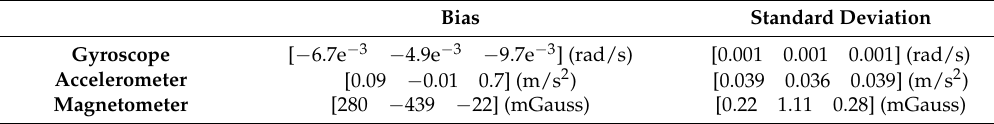
Table 1. Specifications of the sensors in the proposed AHRS.